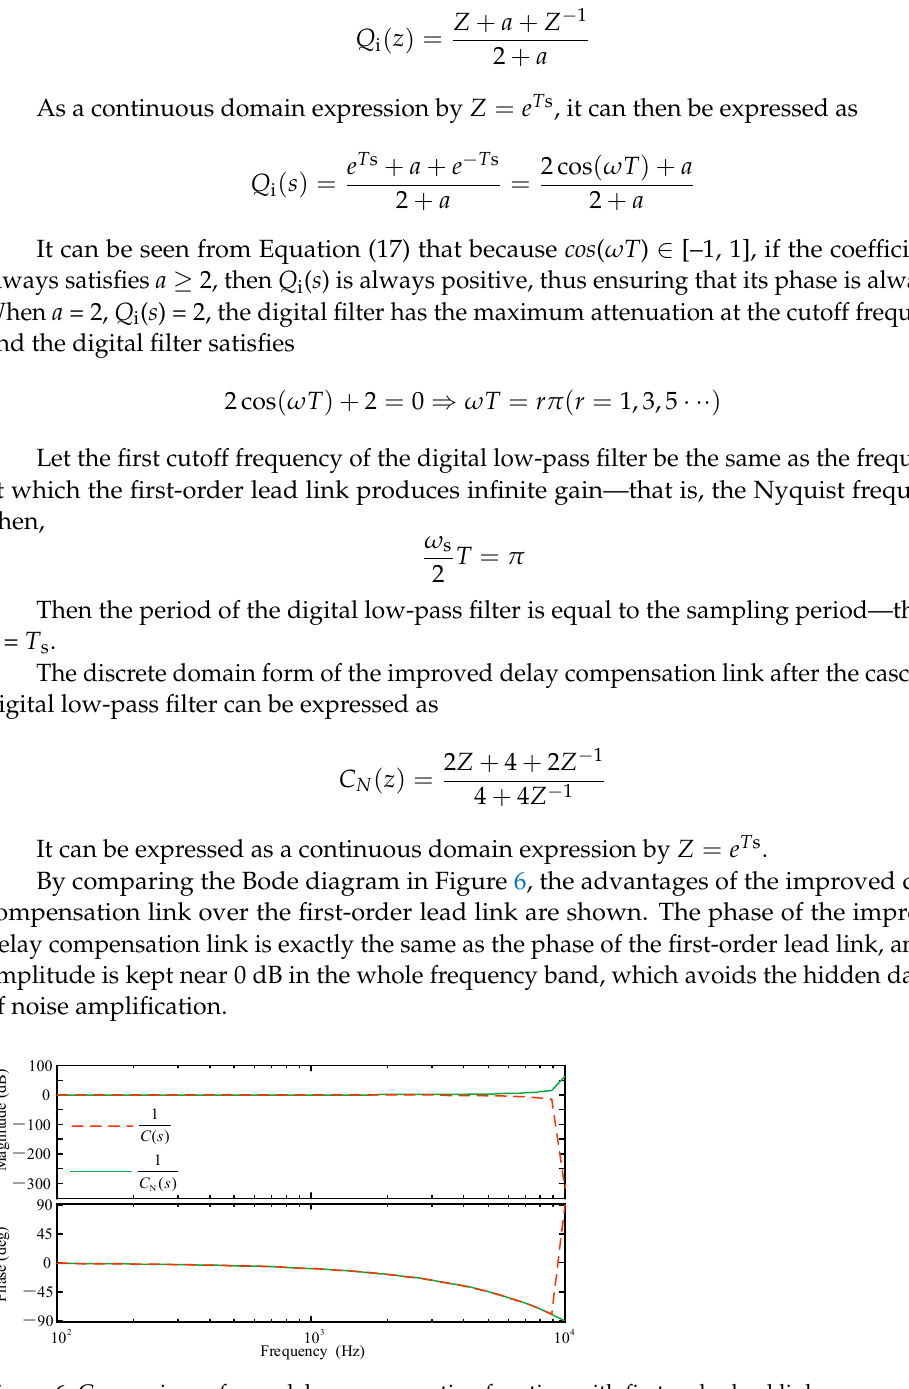
Figure 7. Insertion position of delay compensation function. When the delay compensation link is inserted in compensation location 2, the open- loop transfer function of the inverter system can be expressed as (cid:1833) C2 ((cid:1871)) =